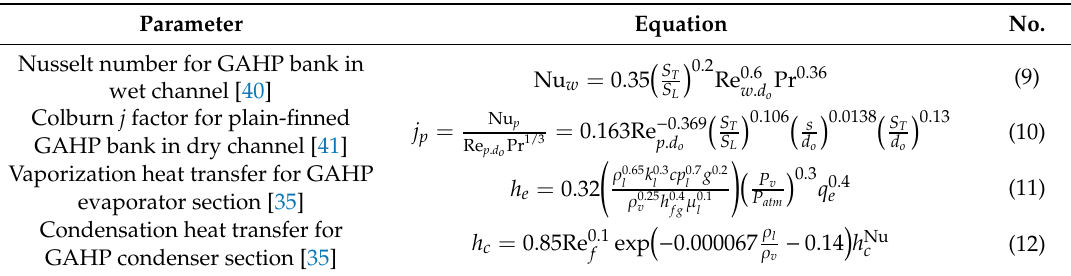
Table 2. Details of the calculated heat transfer coefficients.